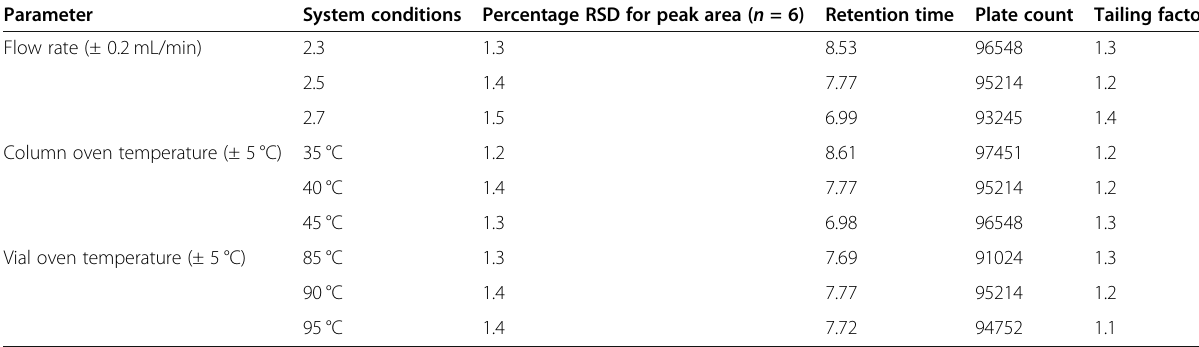
Table 21 Robustness study results of acetone Parameter